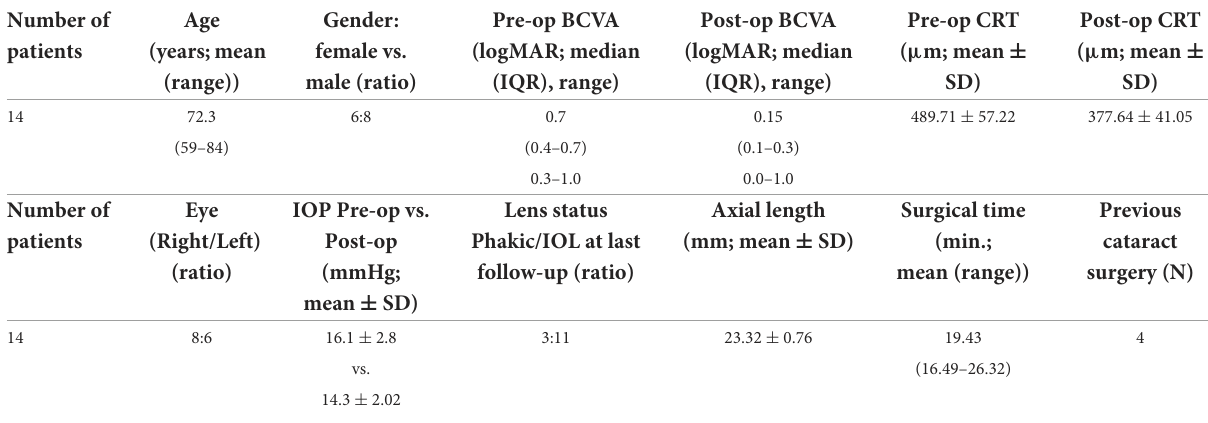
TABLE 1 Characteristics of the studied patients.